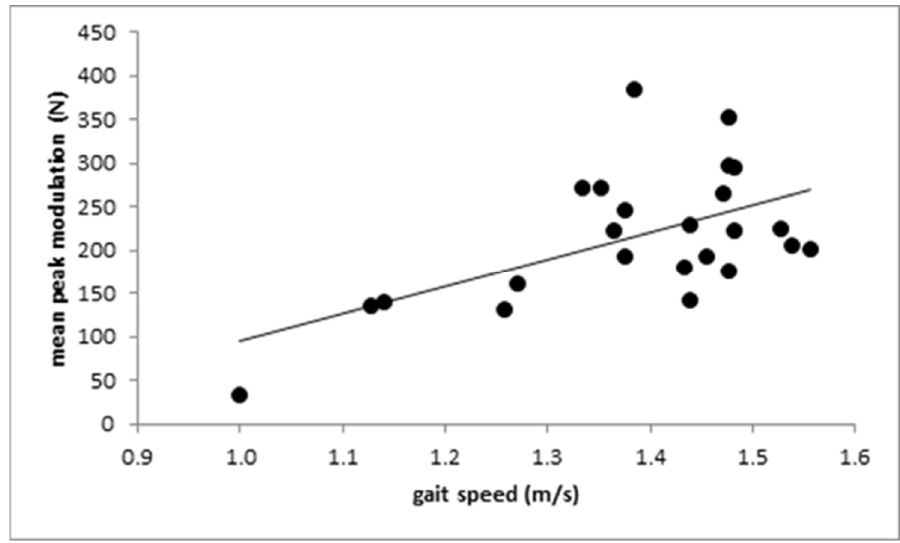
Figure 5. The positive correlation between the height of the “push-off” peak PD2 above the midstance amplitude V1A and gait speed.